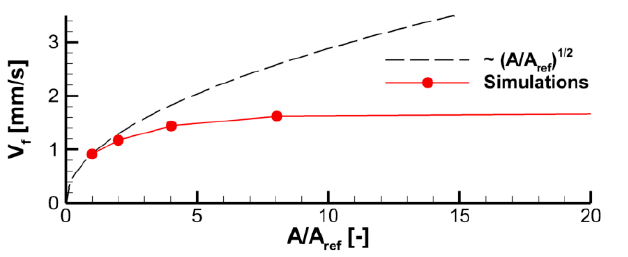
Figure 14. Effect of the pre-exponential factors of volatile oxidation reaction rate on velocity of flame propagation. flame propagation.